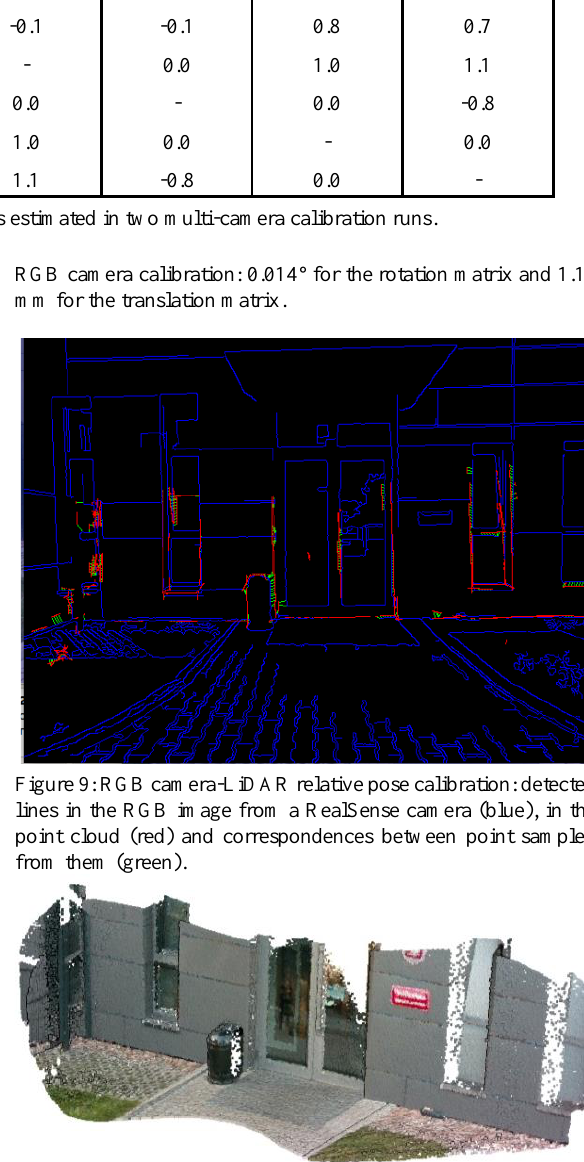
Figure 10: LiDAR point cloud coloured with the RGB camera after the estimation of the relative orientation between the